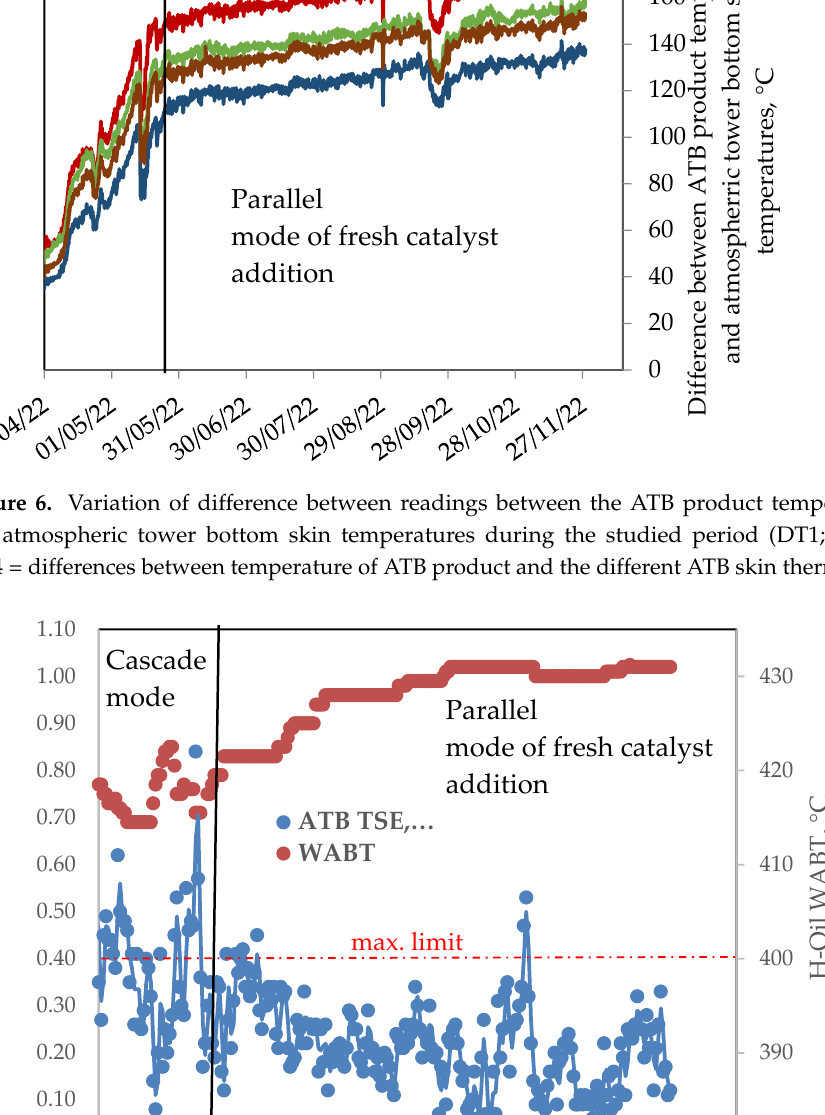
Figure 6. Variation of difference between readings between the ATB product temperature and the atmospheric tower bottom skin temperatures during the studied period (DT1; DT2, DT3, DT4 = dif- ferences between temperature of ATB product and the different ATB skin thermocouples).